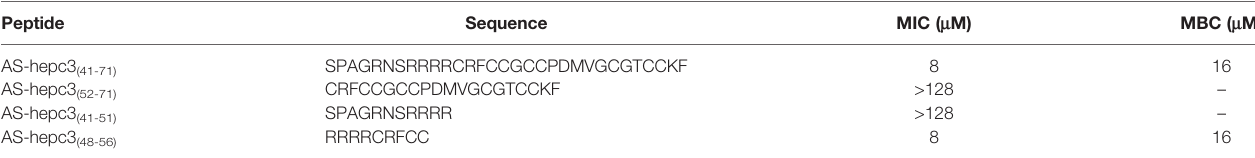
TABLE 1 | The antimicrobial activity of AS-hepc3 – derived peptides against P. aeruginosa PAO1. Peptide